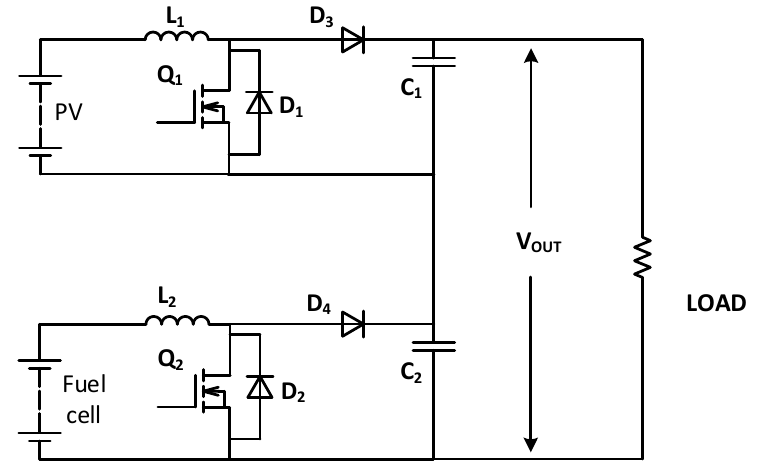
Figure 7. Topology of 3-port, 2-input boost multiport converter.